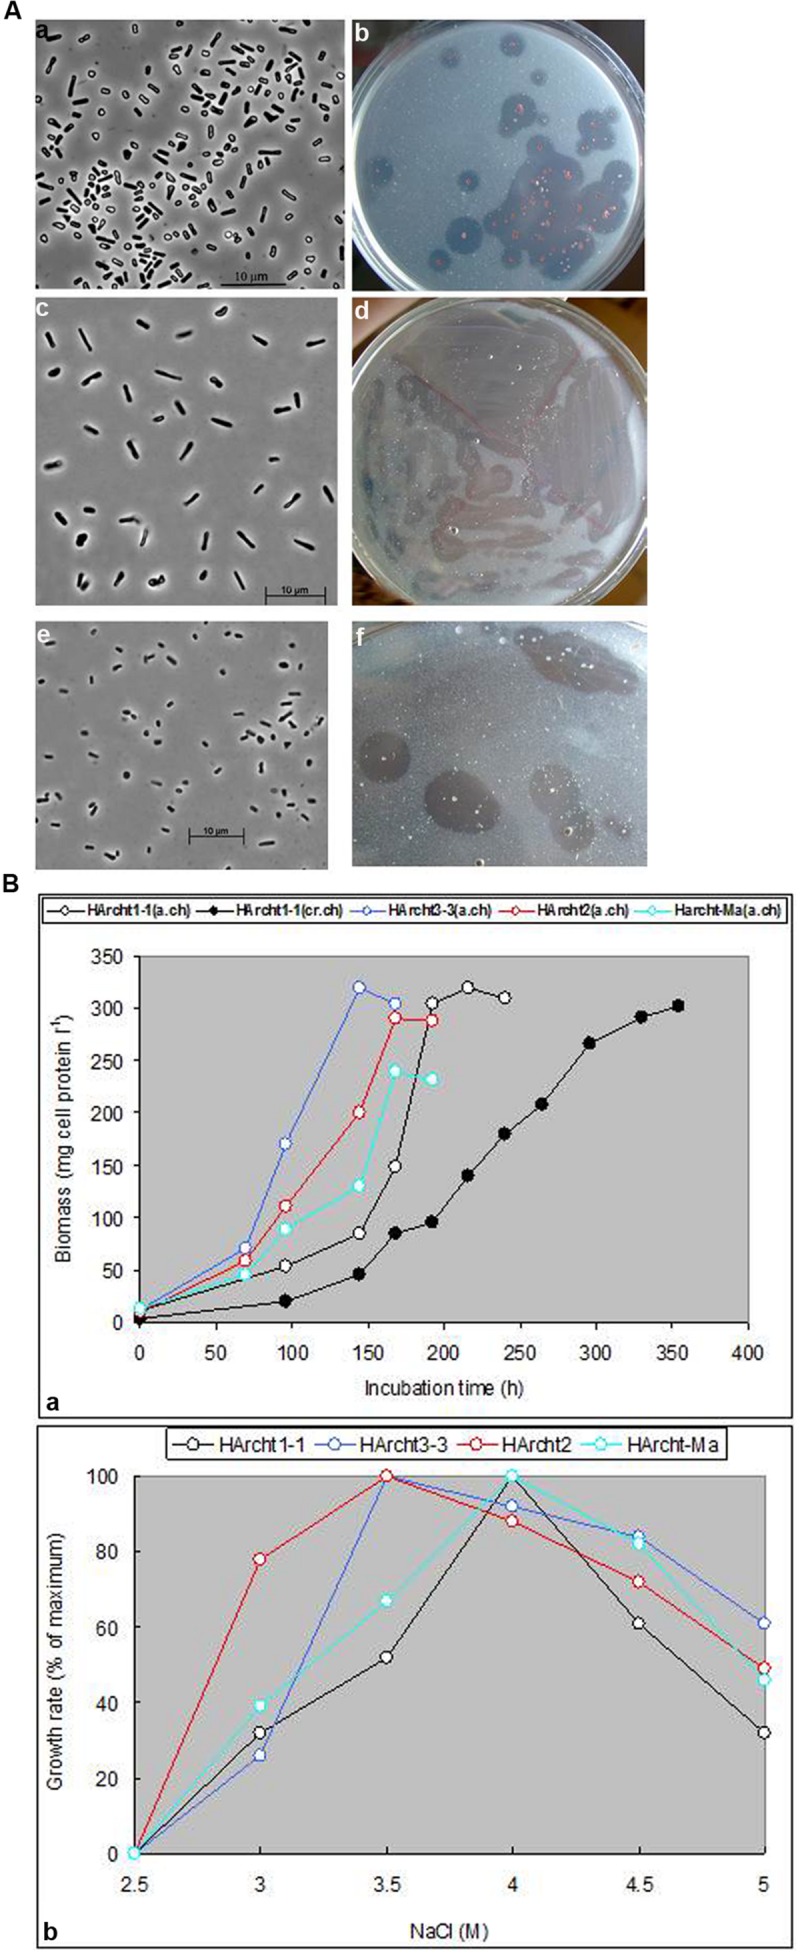
(A) Cell and colony morphology of haloarchaea grown on amorphous chitin at 4 M NaCl. (a,b) Strain HArcht1-2; (c,d) Strain HArcht2; (e,f) Strain HArcht-Bsk. (B). Effects of NaCl on growth of haloarchaeal isolates with amorphous (a.ch) or crystalline (cr.ch) chitin as substrate.